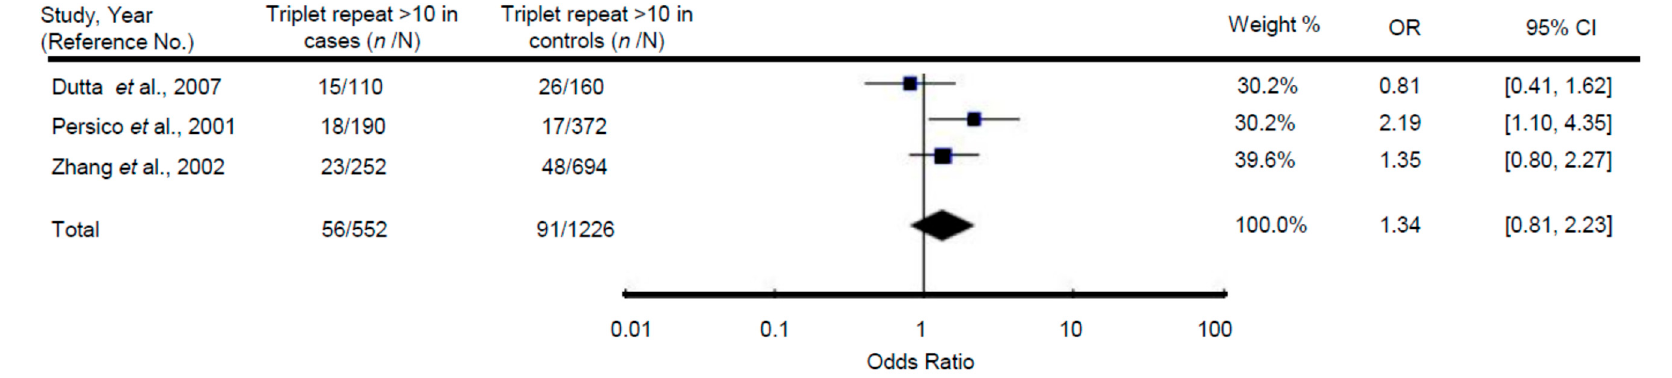
Figure 3. Meta-analysis of the association between the polymorphic trinucleotide repeat (CGG / GCC) within the reelin gene and ASD.